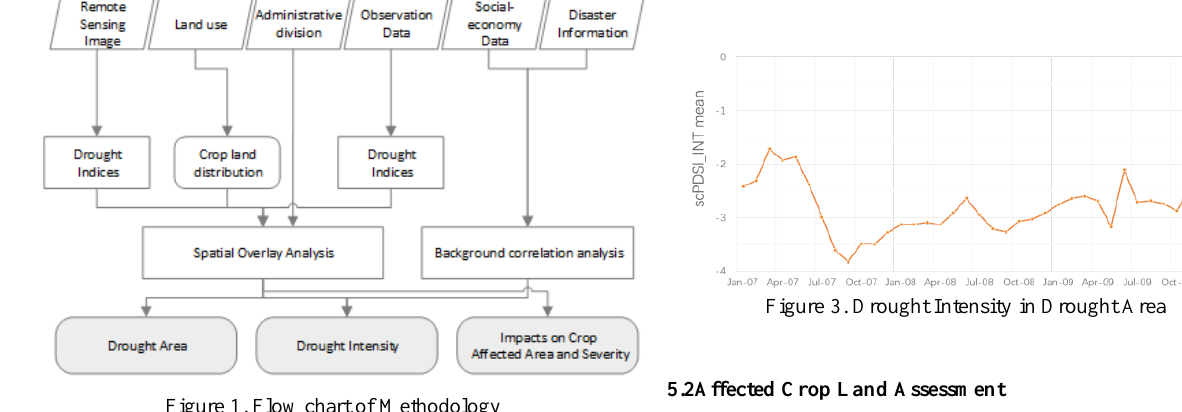
Figure 1. Flow chart of Methodology